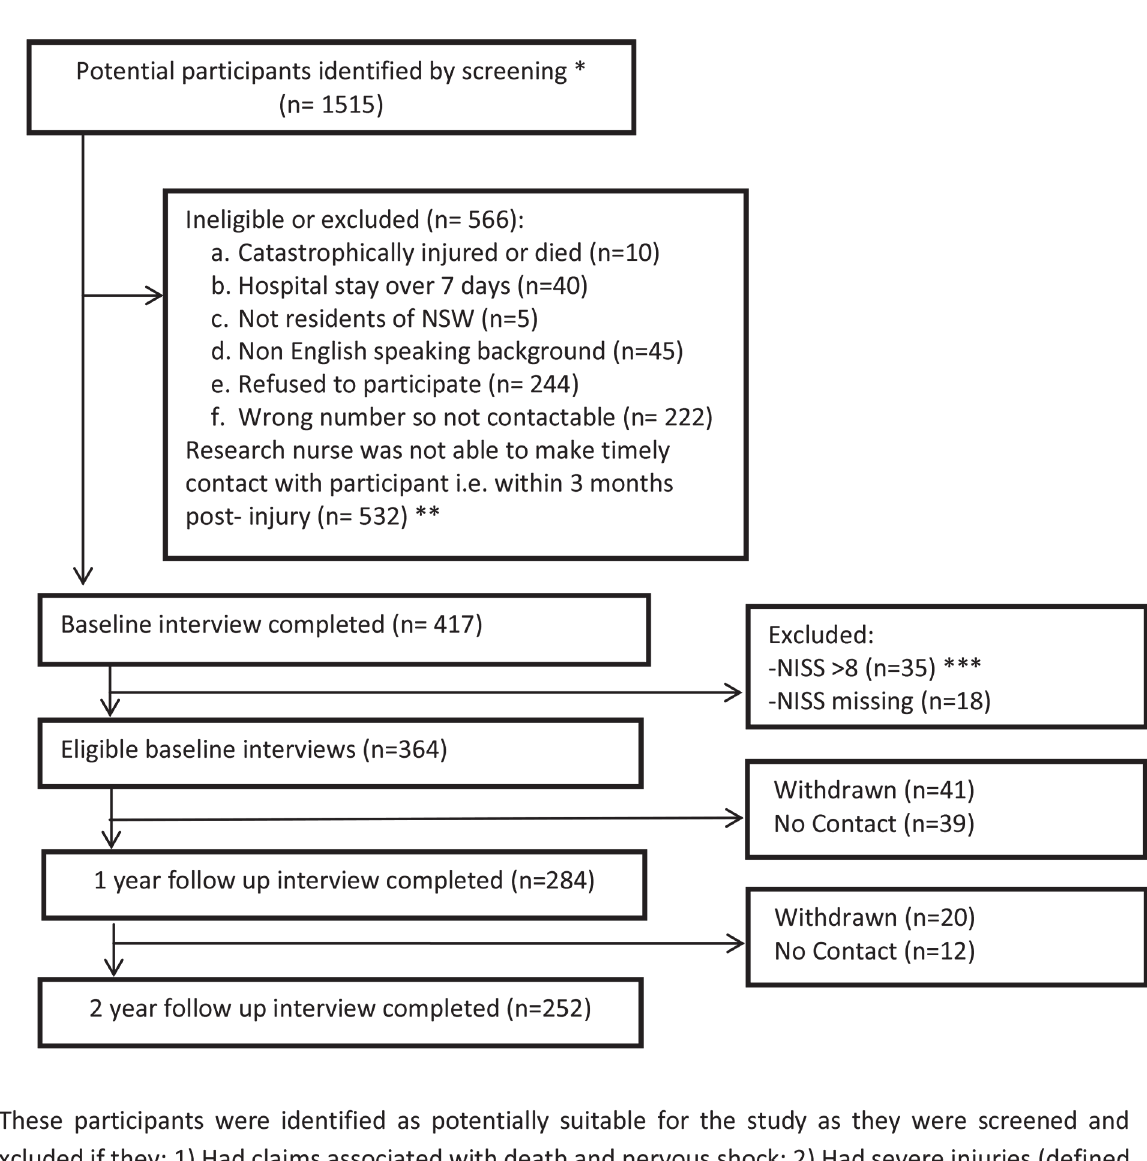
Fig 1. Flowchart of study participation.